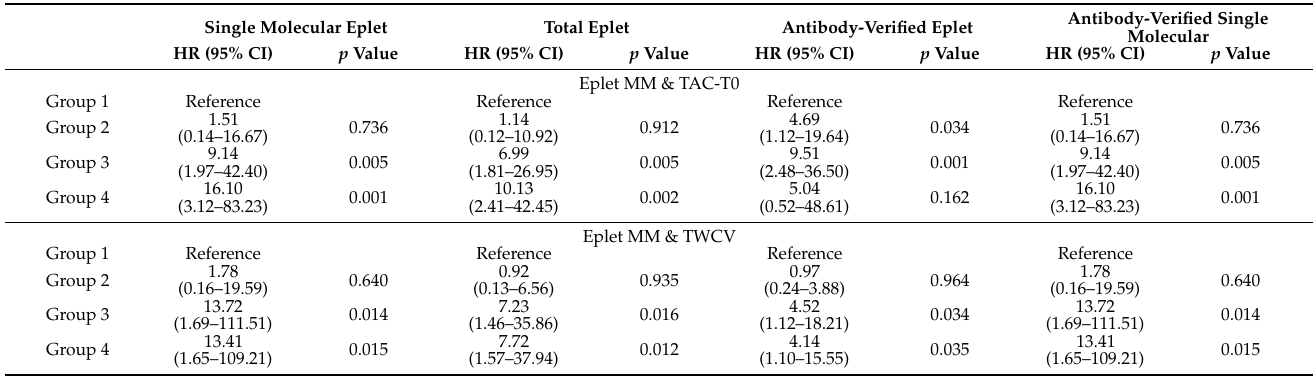
Table 2. Multivarible analysis for class II dnDSA development (n = 175) a